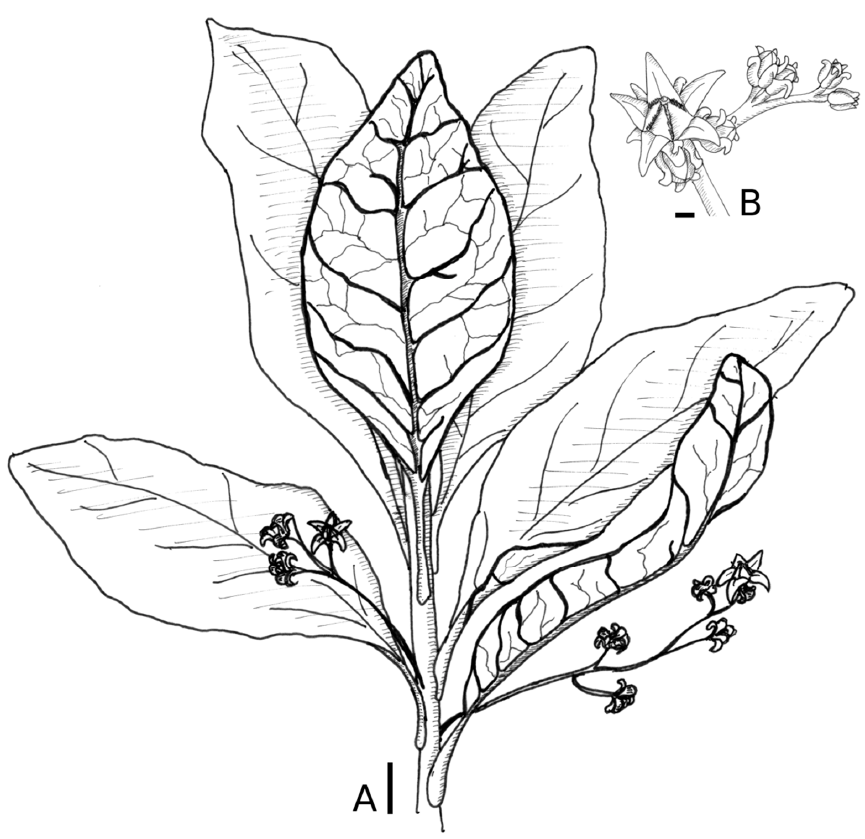
Figure 1. Argophyllum riparium Pillon and Hequet. ( A ) flowering branch, scale = 2 cm; ( B ) portion of an inflorescence, scale = 1 mm. Drawn from Hequet 4662 by Thierry Sanchiz.